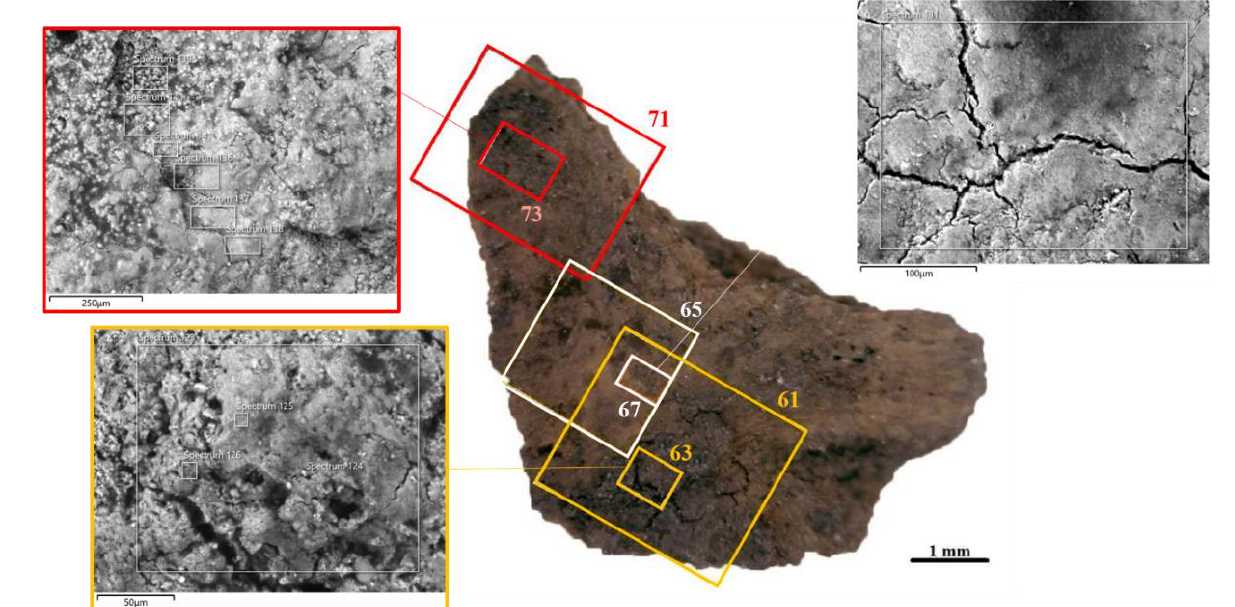
Figure 5. Schematic of the areas investigated by SEM-EDS for sample 1. Areas 61 and 63 (colored in yellow) were characterized by a large dark spot with fractures. The central area 65 and 67 (colored in white) appeared more homogeneous in a brown color. Colored in red, there was a black part that seem thinner (detail 73), while the rest of the surface had an intermediate color between black and brown (area 71). SEM images are related to detail 63 (in yellow), detail 67 (in white), detail 73 (in red).